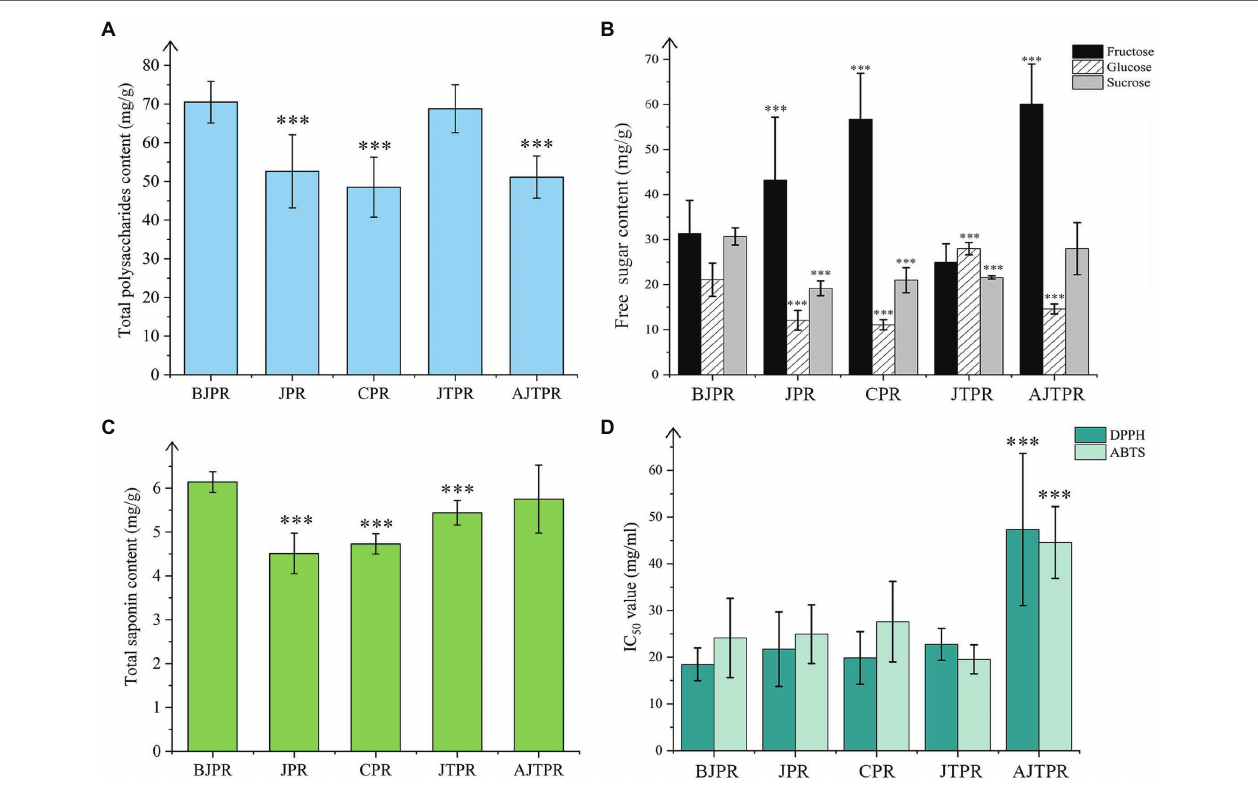
FIGURE 3 | Total polysaccharide content of the five different types of Huangjing (A) ; Three sugars (fructose, glucose, and sucrose) content of the five different types of Huangjing (B) ; total saponin content of the five different types of Huangjing (C) ; DPPH and ABTS of antioxidant ability of the five different types of Huangjing (D) . BJPR, “ BaiJi -type” Polygonati rhizoma; JPR, “ Jiang -type” Polygonati rhizoma; CPR, “ Cylinder -type” Polygonati rhizoma; JTPR, “ JiTou -type” Polygonati rhizoma; and AJTPR, atypical “ JiTou -type” Polygonati rhizoma (***compared with BJPR, p <